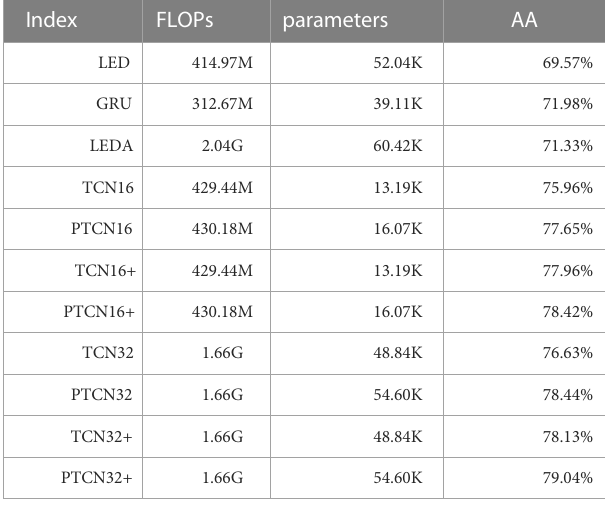
TABLE 1 Floating point operations (FLOPs), number of parameters, and average accuracy (AA) of the proposed and comparison